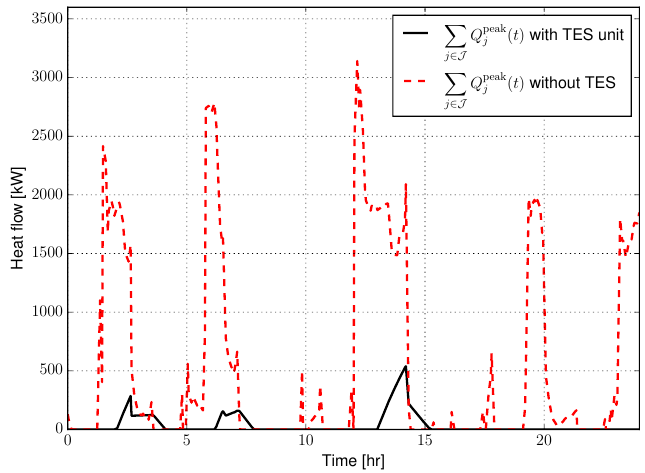
Figure 8. Total peak-heating supply for the case with and without a TES unit.